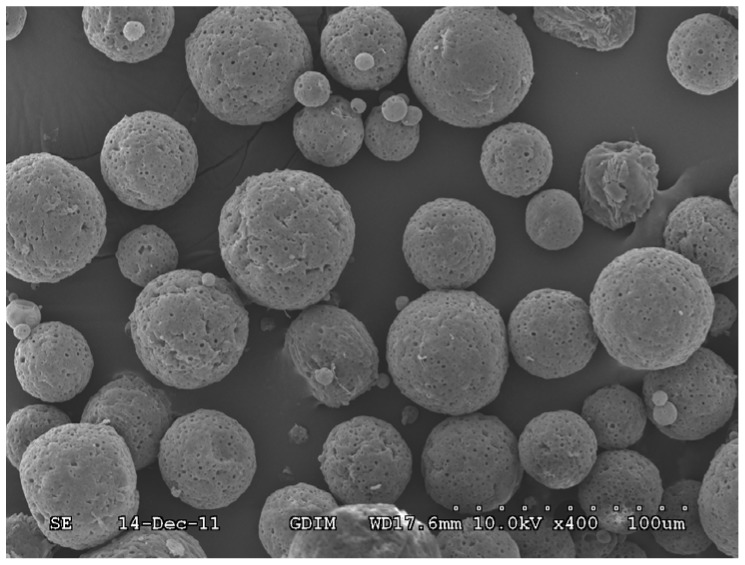
Scanning electron micrograph of the formed microsponges (original magnification ×400).
The length of all the dots is 100 µm.